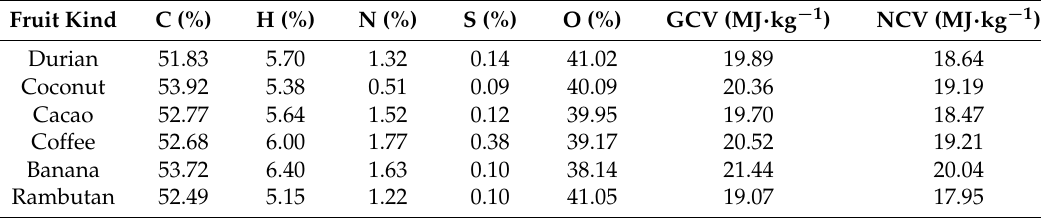
Table 8. Elemental compositions of fruit waste biomass kinds in dry ash free state (d.a.f.).